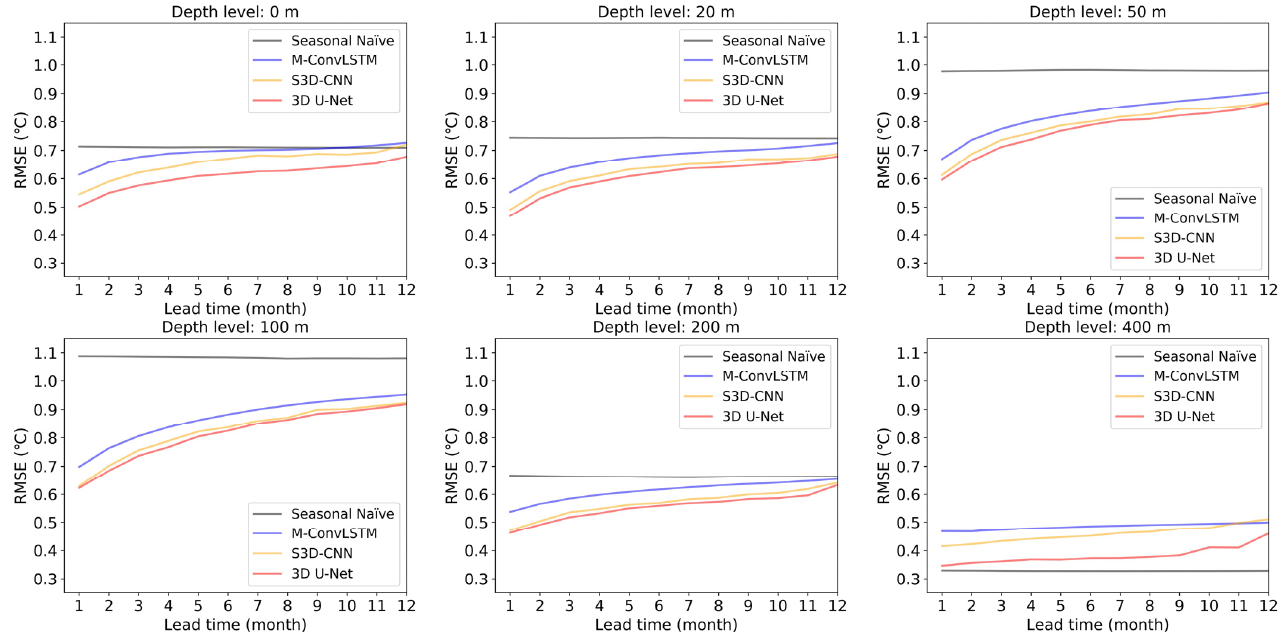
Figure 6. RMSE curves of the compared methods against lead times of 1–12 months for selected depth levels.